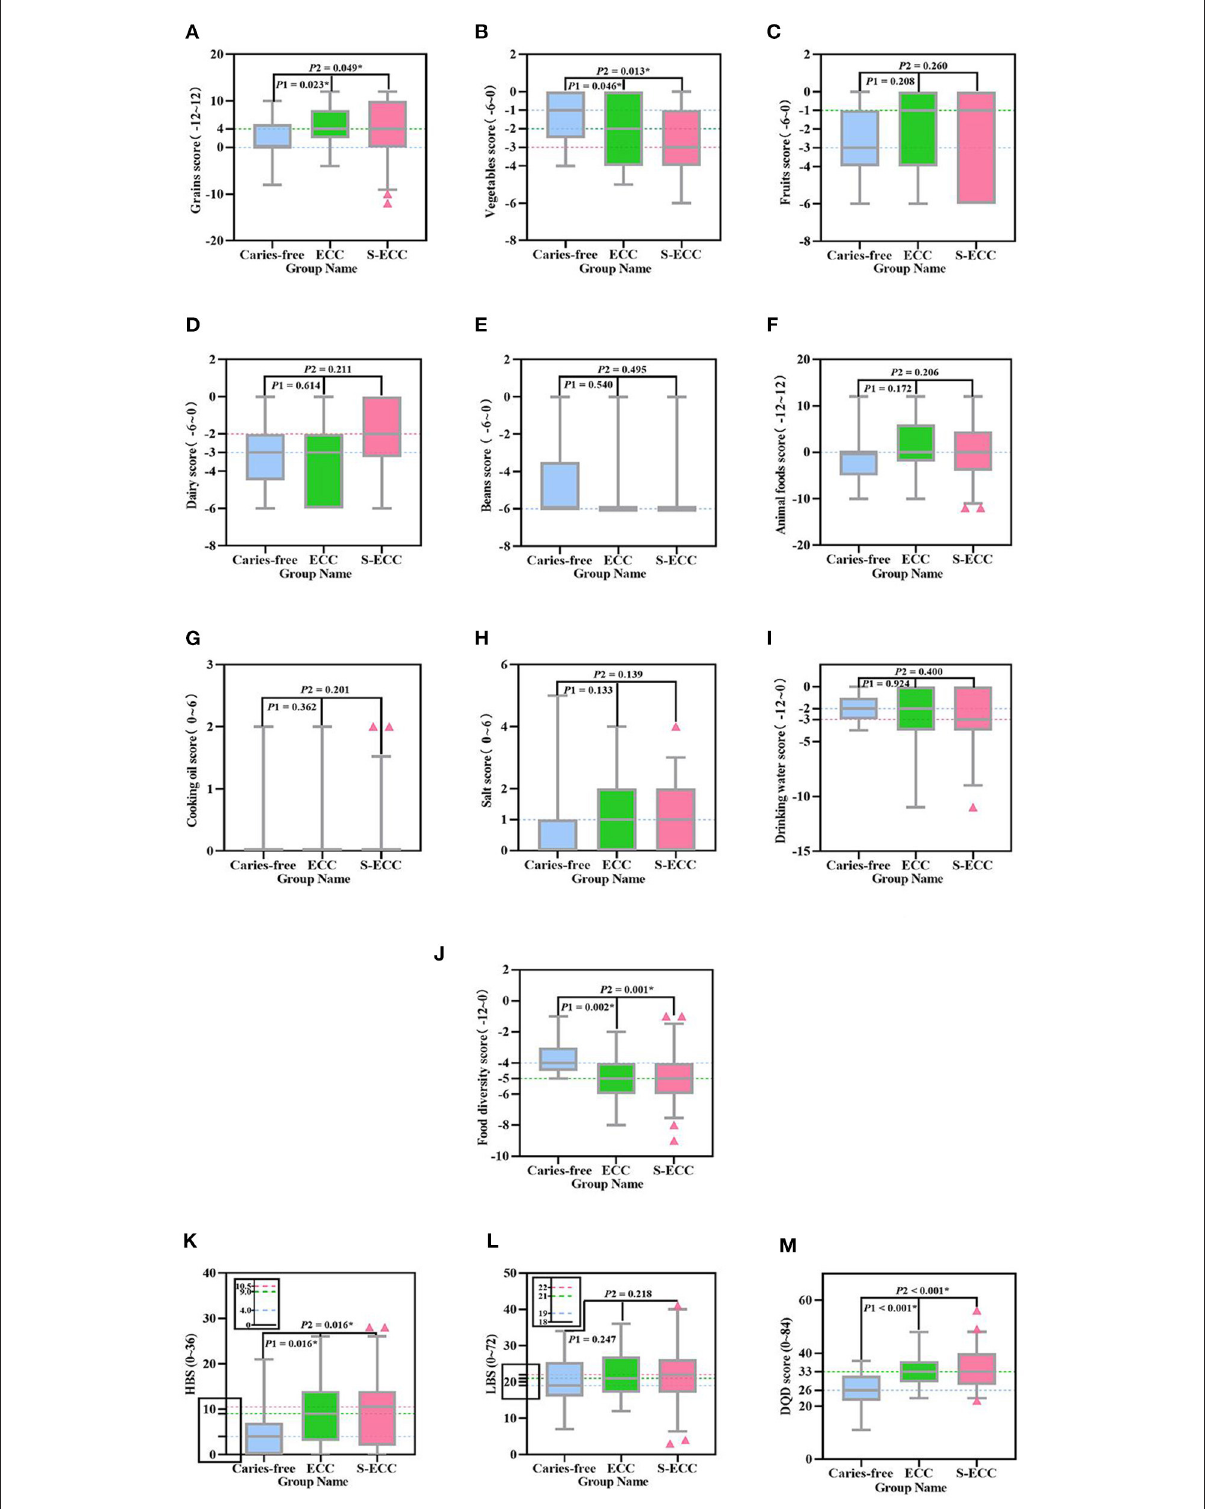
FIGURE1 Distribution and comparison of DBI_C indicators scores, HBS, LBS, and DQD score among the three groups. The distribution and Comparison of (A) Grains score, (B) Vegetables score, (C) Fruits score, (D) Dairy score, (E) Beans score, (F) Animal foods score, (G) Cooking oil score, (H)